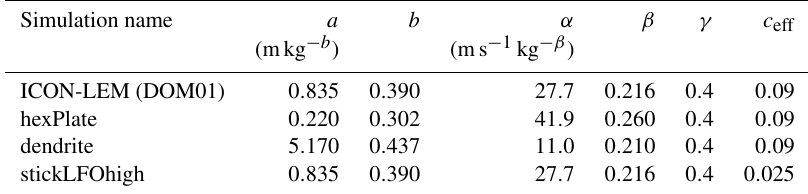
Table 3. Power-law coefficients for the maximum diameter D and terminal fall velocity v of particles with mass m and parameters de- termining the temperature-dependent ( T ) sticking efficiency E stick (T ) of ice hydrometeor collisions used in the microphysical sensitivity